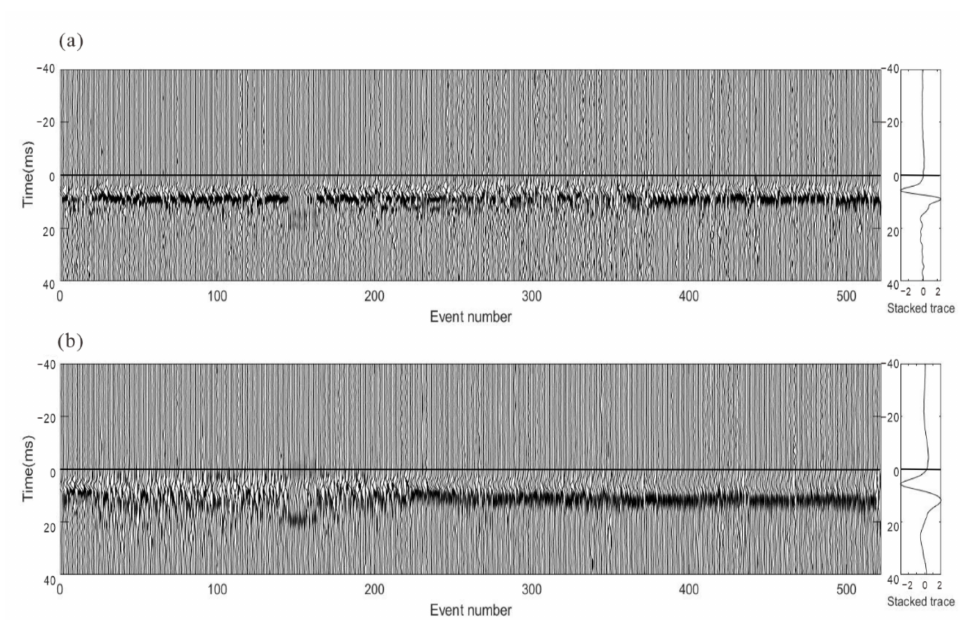
Figure 17. The stacked waveform gathers of all events based on adjusted picks. The horizontal lines show the arrival times of the stacked waveforms. ( a ) P wave; ( b ) S wave. The recordings are processed by energy balancing and polarity unification.